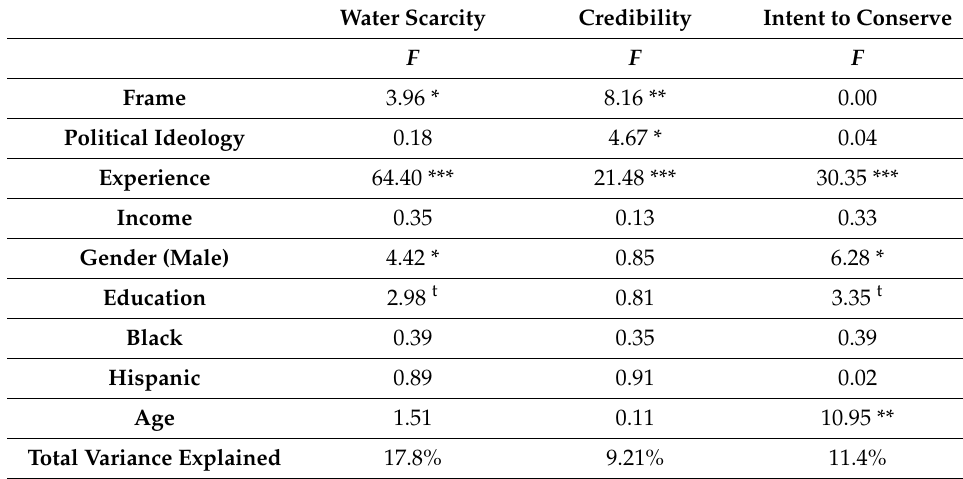
Figure 4. Results of the general linear model, showing that the level of experience predicts a person’s intention to conserve water. Table 2. F values for each of the variables for each of the three general linear models. Significance is indicated with asterisks ( t p < 0.10, * p < 0.05, ** p < 0.01, *** p < 0.001) and is based on the Type III sums of squares.